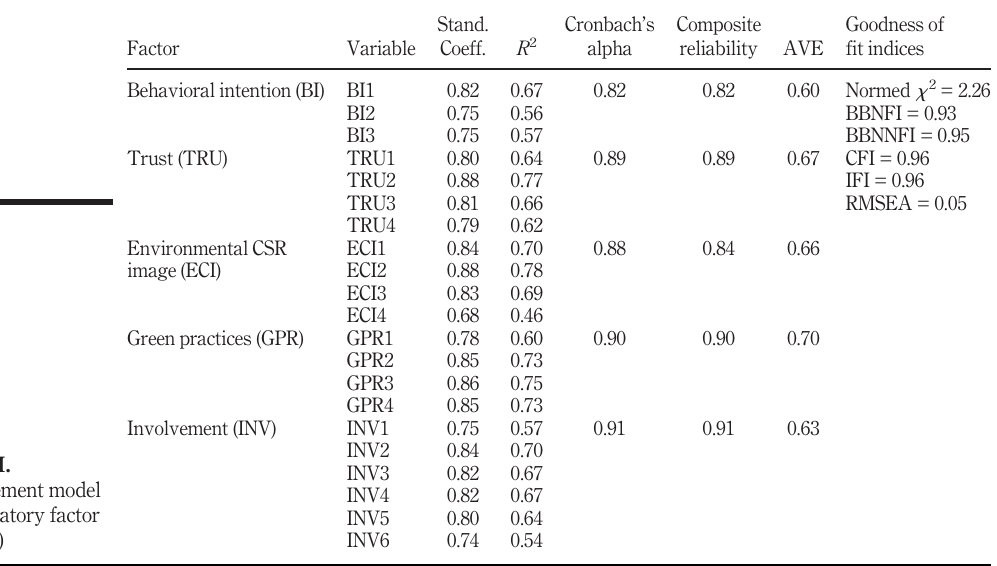
Table II. Measurement model (con fi rmatory factor